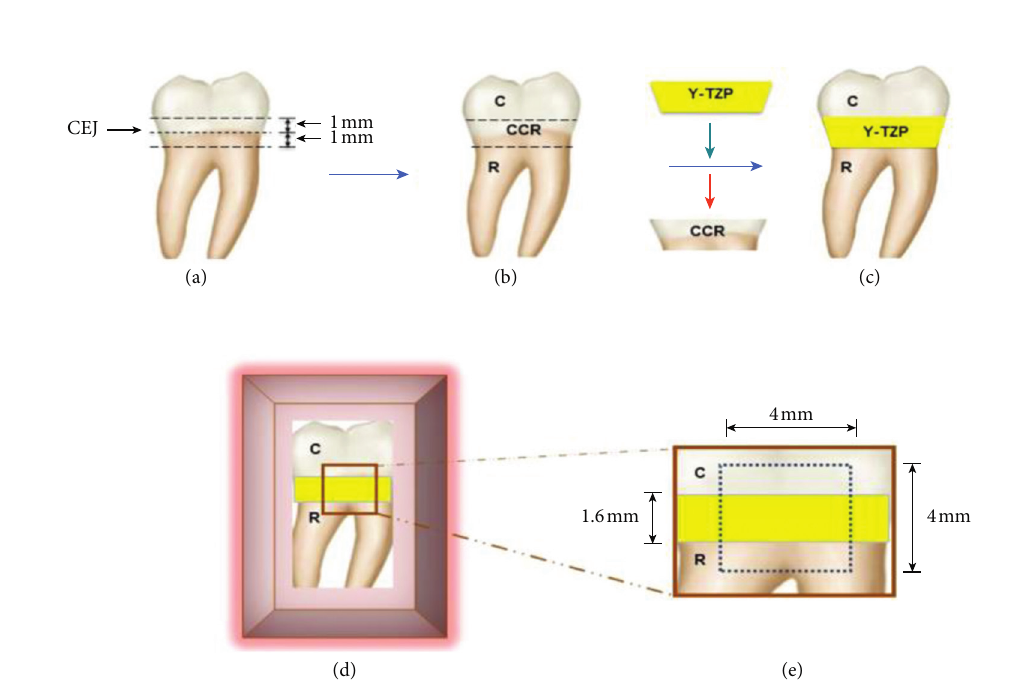
Figure 1: Human third molar (a) was sectioned at 1mm below and above cementoenamel junction (CEJ) (b). The crown-CEJ-root (CCR) portion was removed and replaced with the yttria-stabilized tetragonal zirconia polycrystalline (Y-TZP) disk by bonding to the crown (C) and root (R) portion using resin cement (c) and then inserted in acrylic block (d) to create a flat surface area of 4 × 4 mm 2 (e).